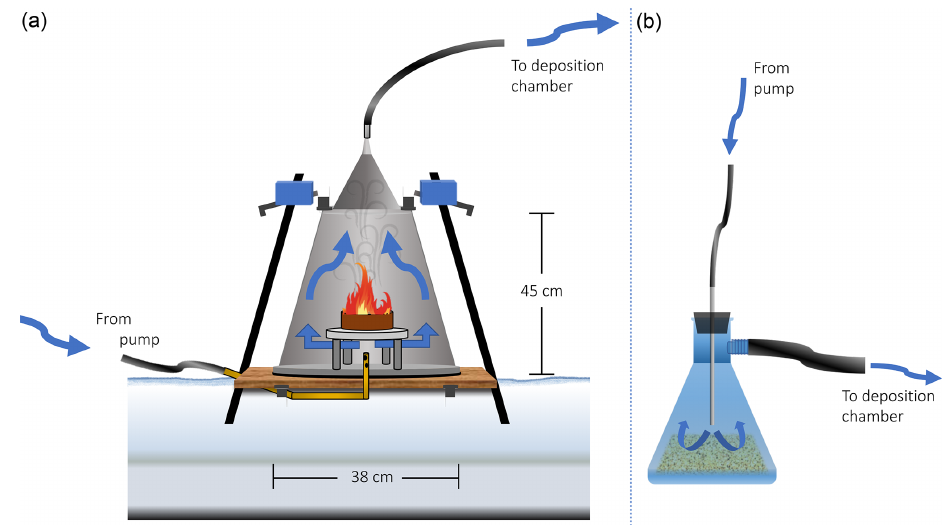
Figure 1. A battery-powered pump provided combustion and transport air into the aerosol production chamber for combustion aerosol (a) , which flows to the deposition chamber at a flow rate of ∼ 5 . 3Lmin − 1 . A 1L glass Büchner flask was used as the entrainment chamber for dry, pulverized dusts (b) , which was provided short, quick bursts of air from a positive-displacement piston pump. The schematics are not drawn to scale.